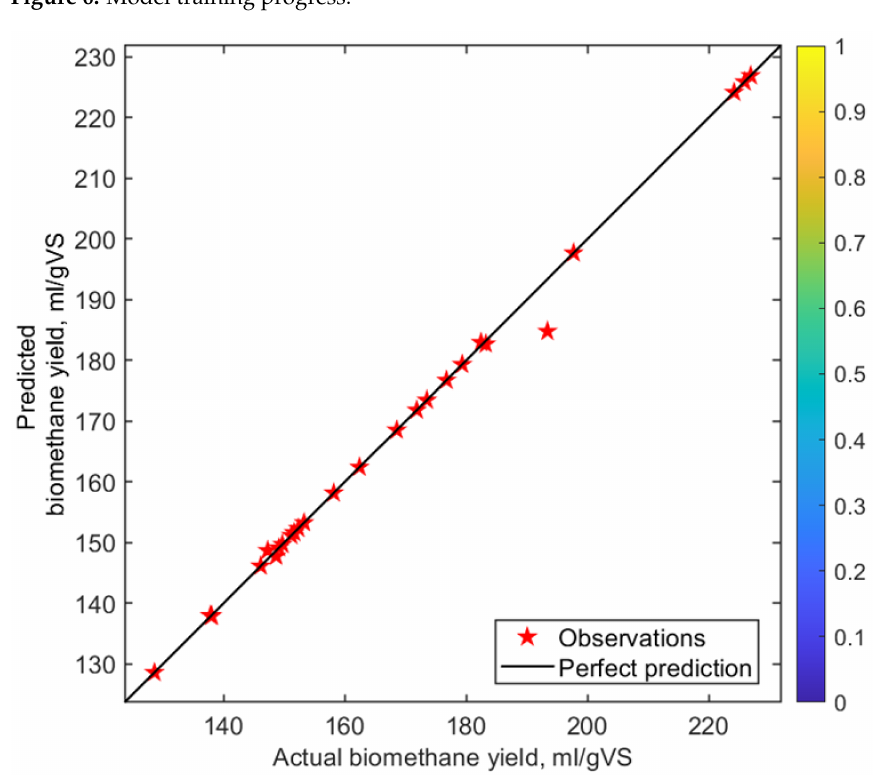
Figure 7. Model’s